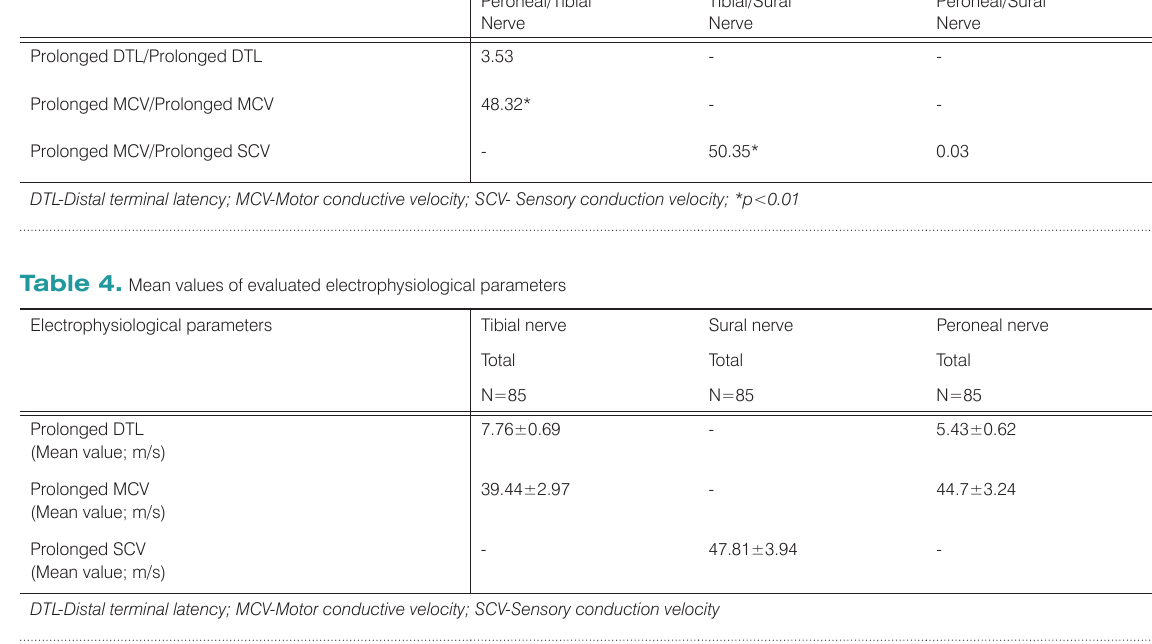
Table 5. Statistical interpretation of patients with prolonged evalu- ated electrophysiological parameters due to the gender χ 2 test values male/female